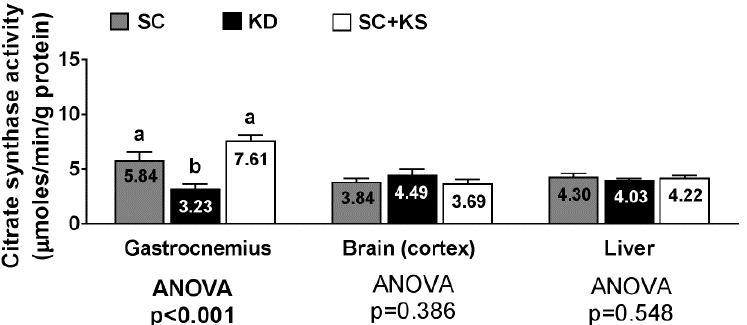
Figure 11. Tissue citrate synthase activity in 8 month-fed rats. Legend: Tissue citrate synthase activity is presented. All bars are presented as mean ± standard error values ( n = 7–8 per group), group means are indicated within each bar and ANOVA p -values are presented below data, and different lettering (“a” versus “b”) indicates significant between-group differences whereas shared lettering (“a” as well as “b” or “a, b”) indicates lack of significant between-group differences. Abbreviations: SC, standard control; KD, ketogenic diet; SC + KS, standard control with supplemental sodium beta-hydroxybutyrate.